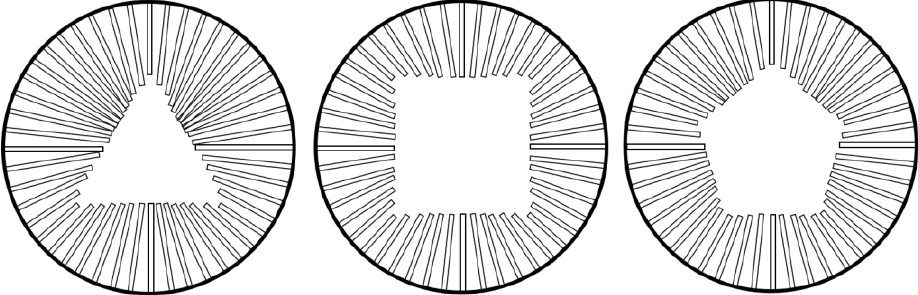
Figure 8. Circle arrangement to implement the shapes.